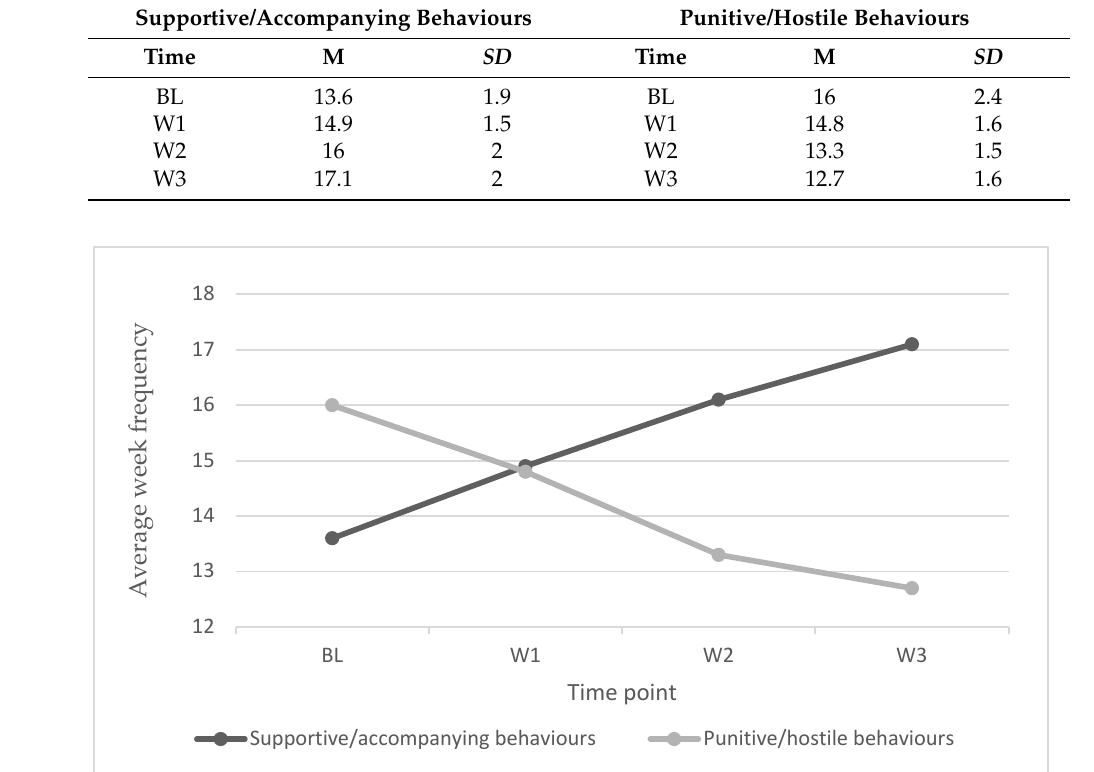
Figure 1. Evolution of family interactions. (Note. Supportive/accompanying and punitive/hostile interactions over the three weeks the intervention was implemented.).